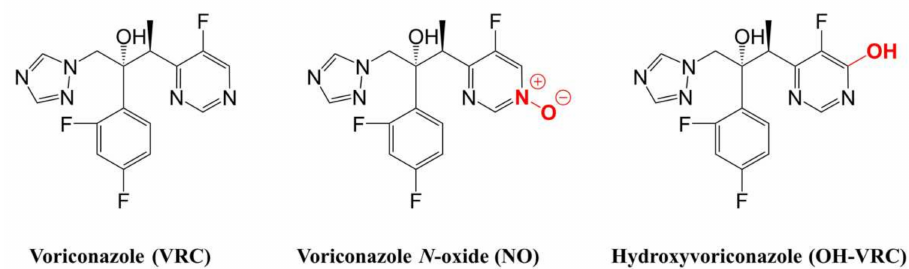
Figure 1. Chemical structures of voriconazole and its two metabolites, voriconazole N -oxide and